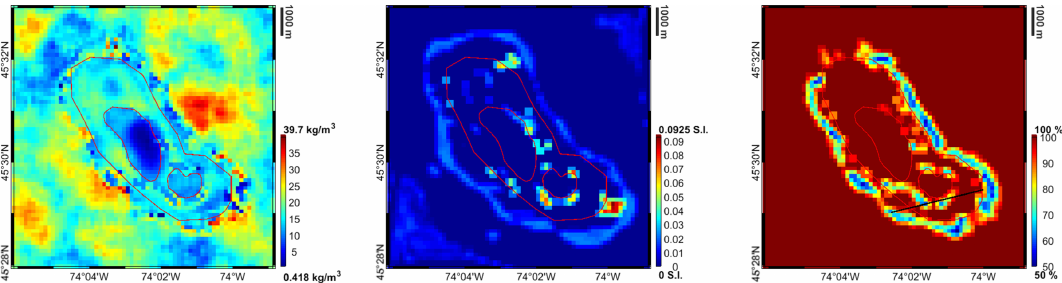
Figure 8. Predicted accuracy at 1 km depth in terms of density ( left ), susceptibility ( centre ) and label ( right